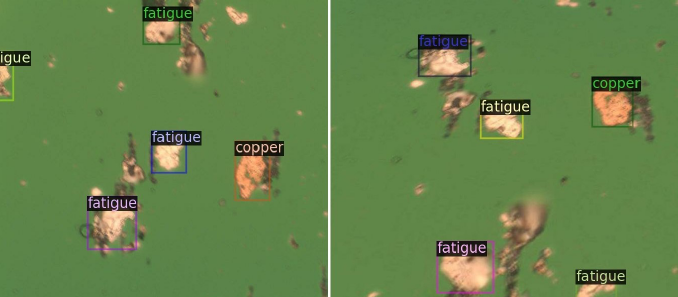
Figure 2. The features of wear debris defect have small inter-category variance, between fatigue and